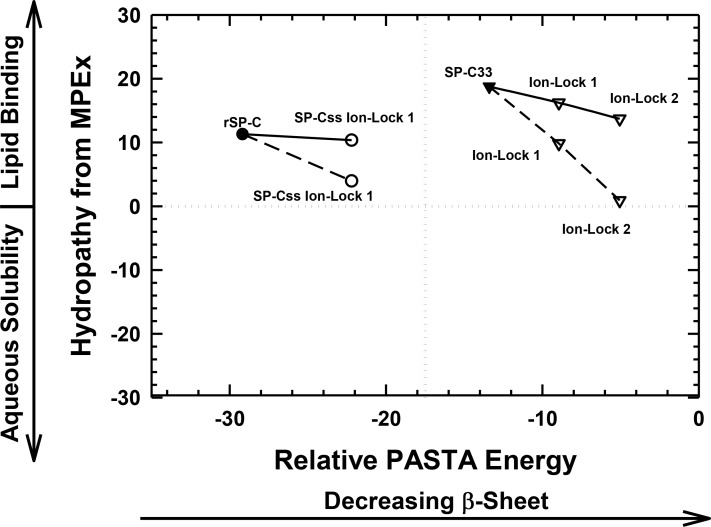
Plot of hydropathy (kcal/mol) vs. relative PASTA energy values, determined for the rSP-C, SP-Css ion-lock 1, SP-C33 and SP-C33 ion-lock 1 and SP-C33 ion-lock 2 peptides.Hydropathy (kcal/mol) is a measure of the hydrophobic partitioning for helical peptides into transmembrane environments, determined using MPEx. Positive hydropathy predicts elevated lipid binding for helical peptides, while more negative values forecast greater water-solubility. Relative energy values were from PASTA, with less negative values reflecting a lower propensity to form β-sheet. Top-left quadrant: The rSP-C (filled circle) and SP-Css ion-lock 1 (open circles) values are shown. The PASTA energies for rSP-C and SP-Css ion-lock 1 are calculated from the respective segments 7–27, while MPEx hydropathies are determined from the respective segments 12–30. The SP-Css ion-lock 1 value, connected to the rSP-C value by a solid line, reflects the hydropathy for an α-helical peptide with an engaged salt-bridge (i.e., close-range) between Glu−–Lys+. Alternatively, the SP-Css ion-lock 1 value, connected to the SP-C value by a dashed line, indicates a hydropathy with a disengaged salt-bridge (i.e., long-range). The SP-Cff ion-lock 1 values overlap those of SP-Css ion-lock 1. SP-Css and SP-Cff points are not included, because MPEx does not accurately predict the transmembrane insertion of such short helices (i.e., ≤ ∼ 8 residues) (Table 1). Top-right quadrant: The SP-C33 (filled inverted triangles) and SP-C33 ion-lock 1 and 2 (open inverted triangles) values are shown. The PASTA energies for SP-C33, SP-C33 ion-lock 1 and SP-C33 ion-lock 2 are each calculated from the C-terminal segment 6–26, while MPEx hydropathy is determined from each 13–31 segment. The SP-C33 ion-lock values, connected to the parent SP-C33 value by a solid line, reflect the hydropathies of α-helical peptides with engaged salt-bridges between the Glu−–Lys+ pair. Alternatively, the SP-C33 ion-lock values, connected to the SP-C33 value by dashed lines, indicate hydropathies with disengaged salt-bridges between the Glu−–Lys+ pairs. See Fig. 1 for sequences.